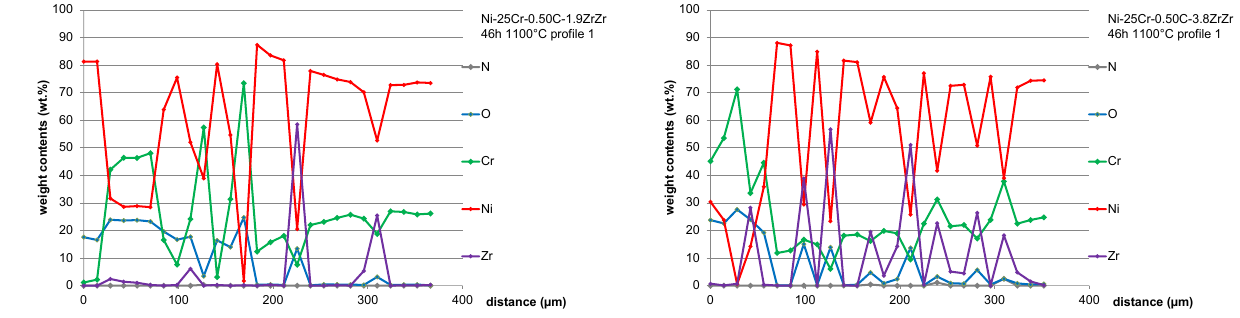
Figure 11. EDS concentration profiles acquired over the external oxide scale and the subsurfaces of the oxidized Ni–25Cr–0.50C–1.9Zr ( left ) and Ni–25Cr–0.50C–3.8Zr alloys ( right ). The low or very low chromium contents close to the oxidation front explain that the oxidation behavior of these Zr–containing alloys was not chromia-forming, and that the mass gain were particularly fast. The external scale is a mix of different oxides,